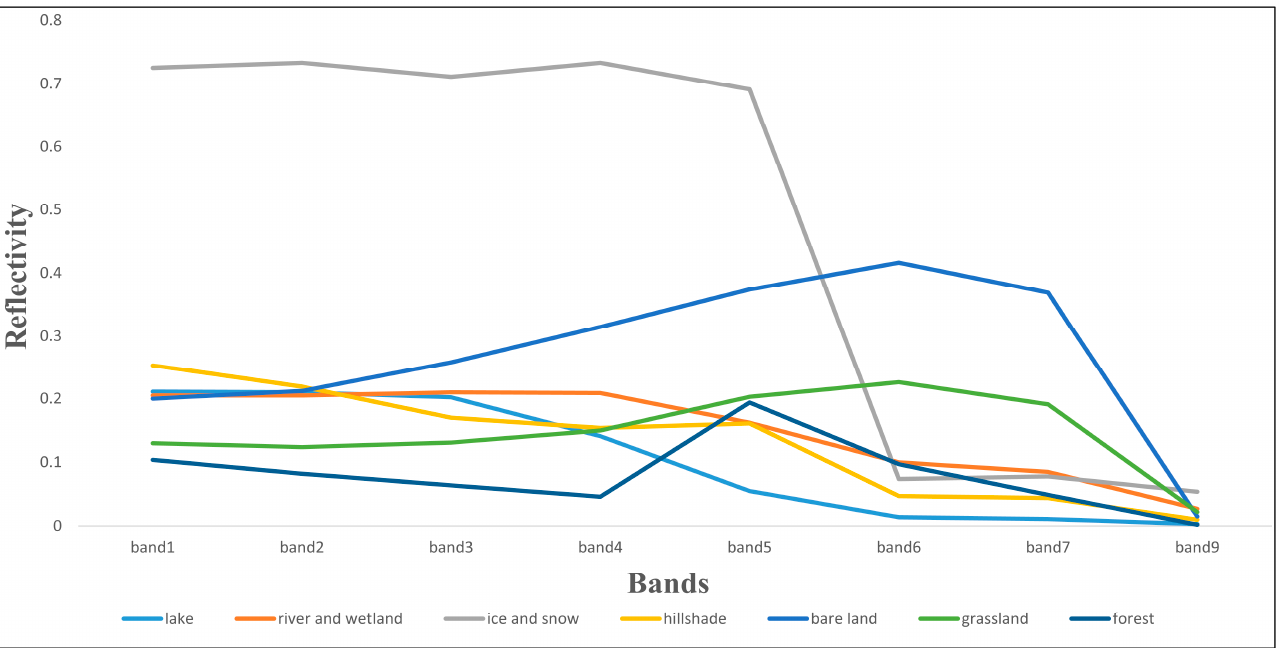
Figure 3. Spectral characteristic curves of typical features on the Tibetan Plateau.